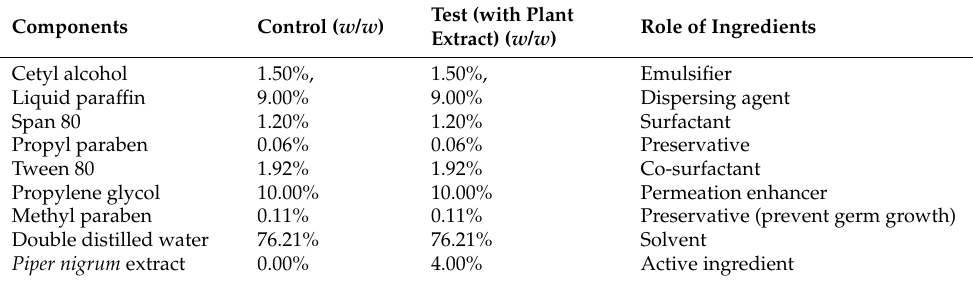
Table 5. Components of control and test